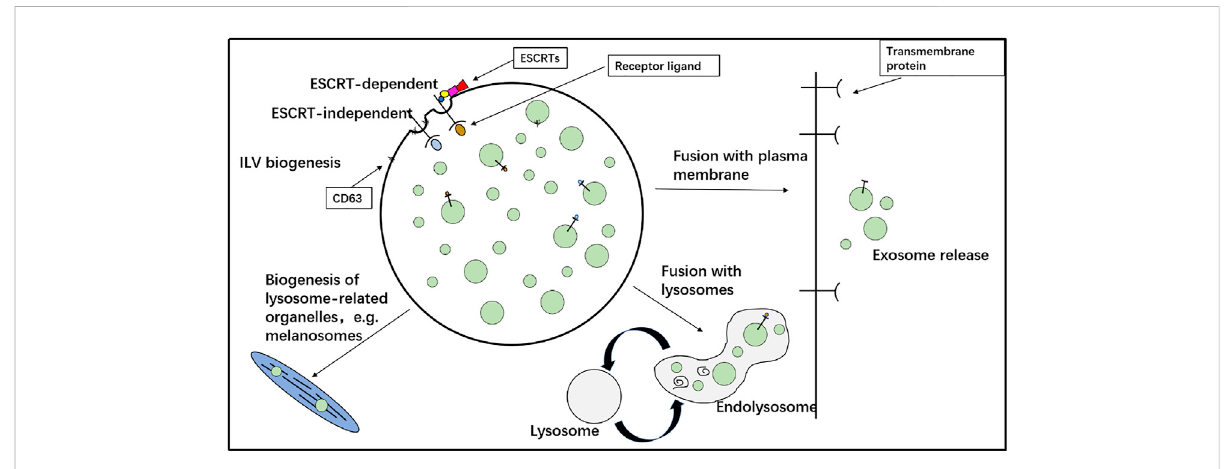
Formation of exosomes. Initially, the cytoplasmic membrane is in the early inner body, whichis again formed in theadvancedinner body to the inner bud and fi nally secreted out of the